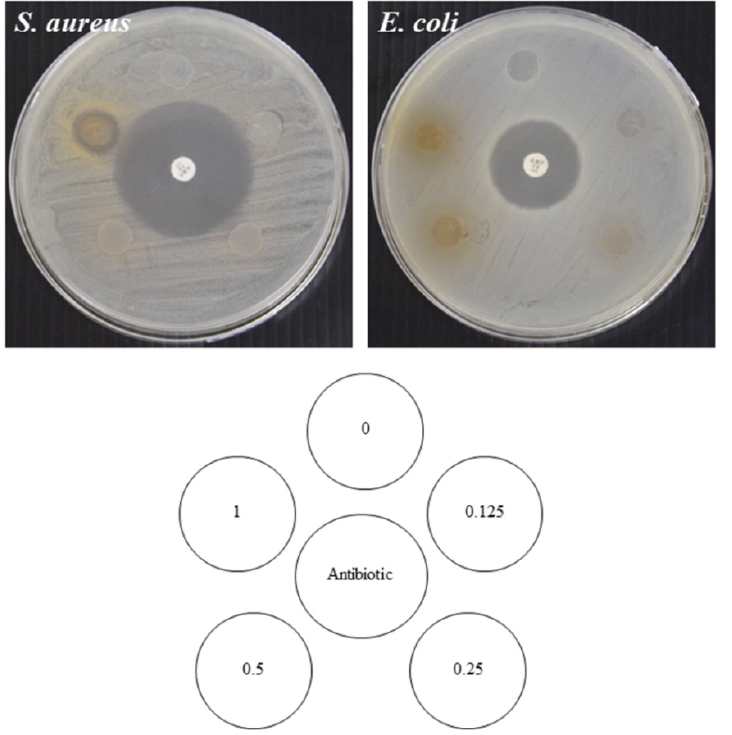
Figure 4. Antimicrobial properties of rice-starch-pectin films incorporated with green tea extract at different concentrations. The numbers designate concentrations of green tea extract, (% w/v ) .